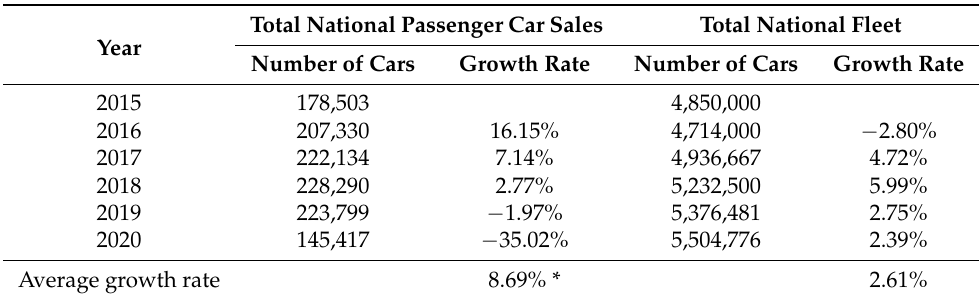
Table 1. Portugal’s total passenger car sales and fleet between 2015 and 2020